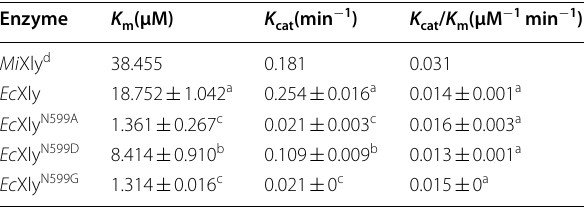
a,b,c The superscript different letters in the same column represent significant difference ( P < 0.05), whereas the superscript same letter in the same column suggests no significant difference ( P > 0.05) d The kinetic data were from Yang et al. (2014)